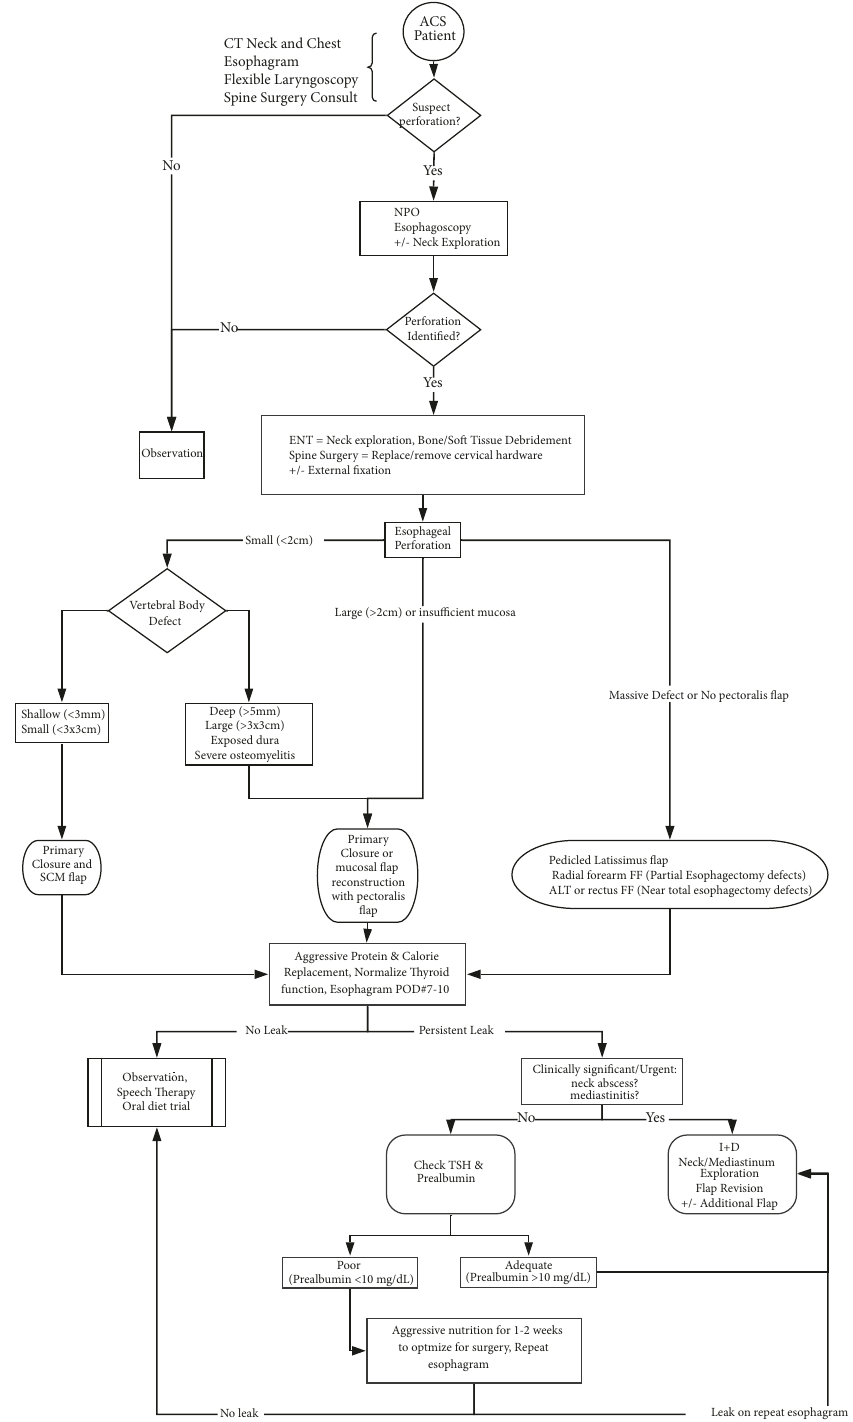
Figure 2: Esophageal perforation management algorithm. ACSS = anterior cervical spine surgery. CT = computed tomogram. NPO = nil per os . SCM = sternocleidomastoid. POD = postoperative day. FF = free flap. I+D = incision and drainage of abscess. This algorithm provides a general guideline for flap selection. However, because the donor flap bulk varies between patients, care must be taken to individualize flap